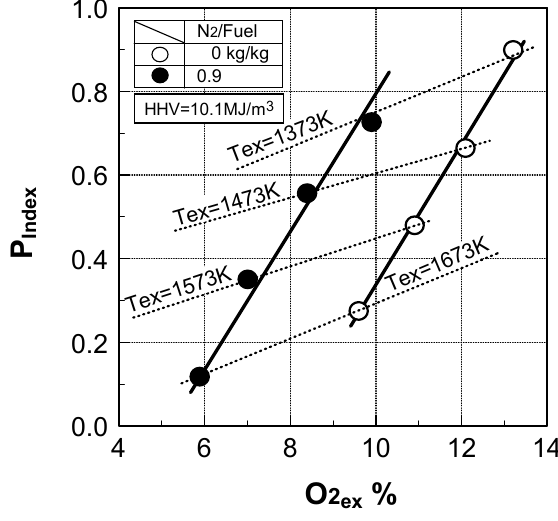
Figure 73. Dependence of NOx emission characteristics on combustion